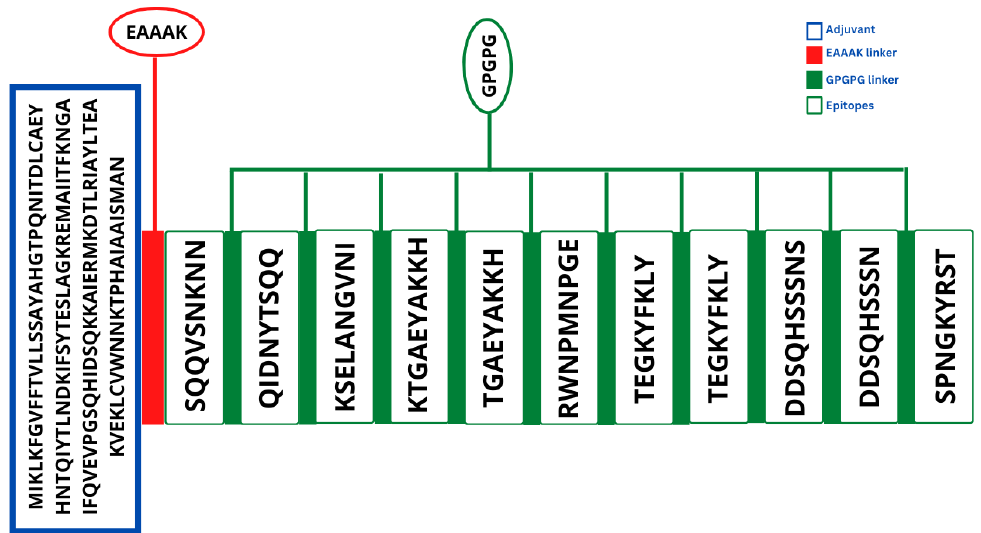
Figure 5. The schematic description of the vaccine construct. The blue colored text box shows the cholera toxin B subunit (adjuvant) sequence. The red colored text box depicts the EAAAK linker. The white colored boxes depict the selected epitopes that are joined by GPGPG linkers, as indicated by the green colored textboxes.